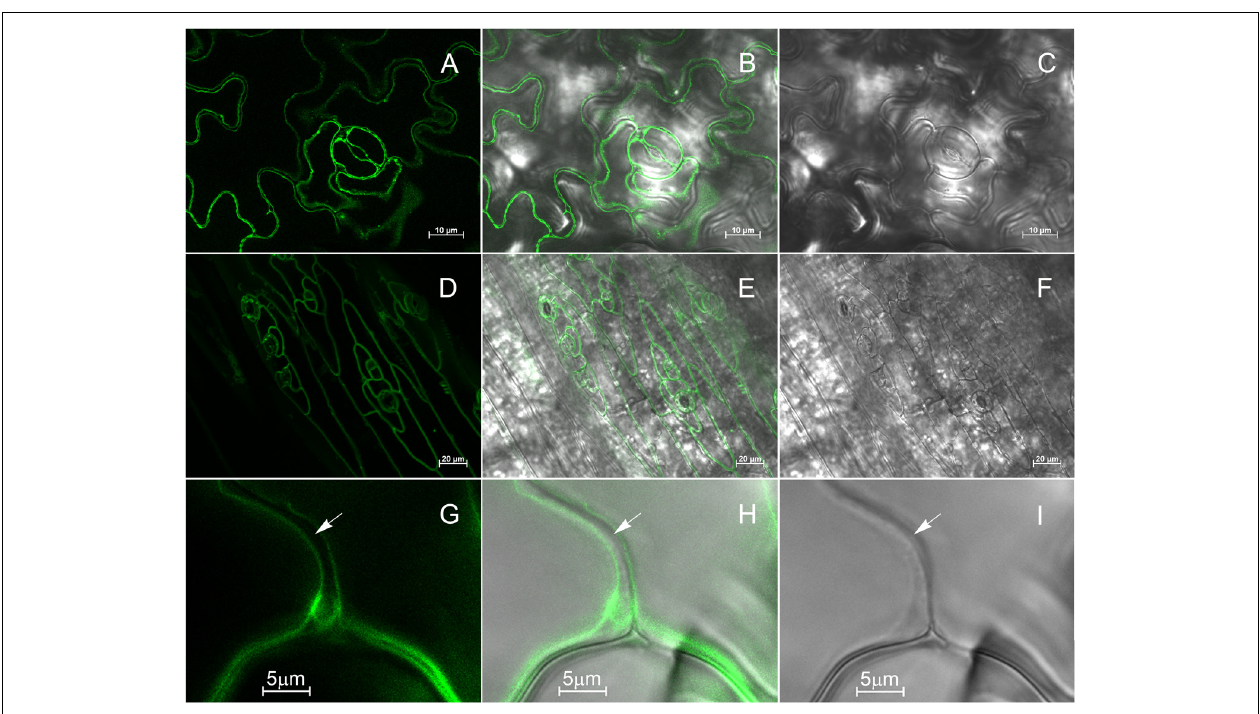
FIGURE 4 | KCO3::GFP is located at the tonoplast. Leaf epidermis (A–C, G–I) or hypocotyl (D–F) from KCO3::GFP transgenic plant were analyzed by epifluorescence microscopy. (A,D,G) : GFP fluorescence; (C,F,I) : brightfield; (B,E,H) : Merge of fluorescence and brightfield.The arrow indicates the cell